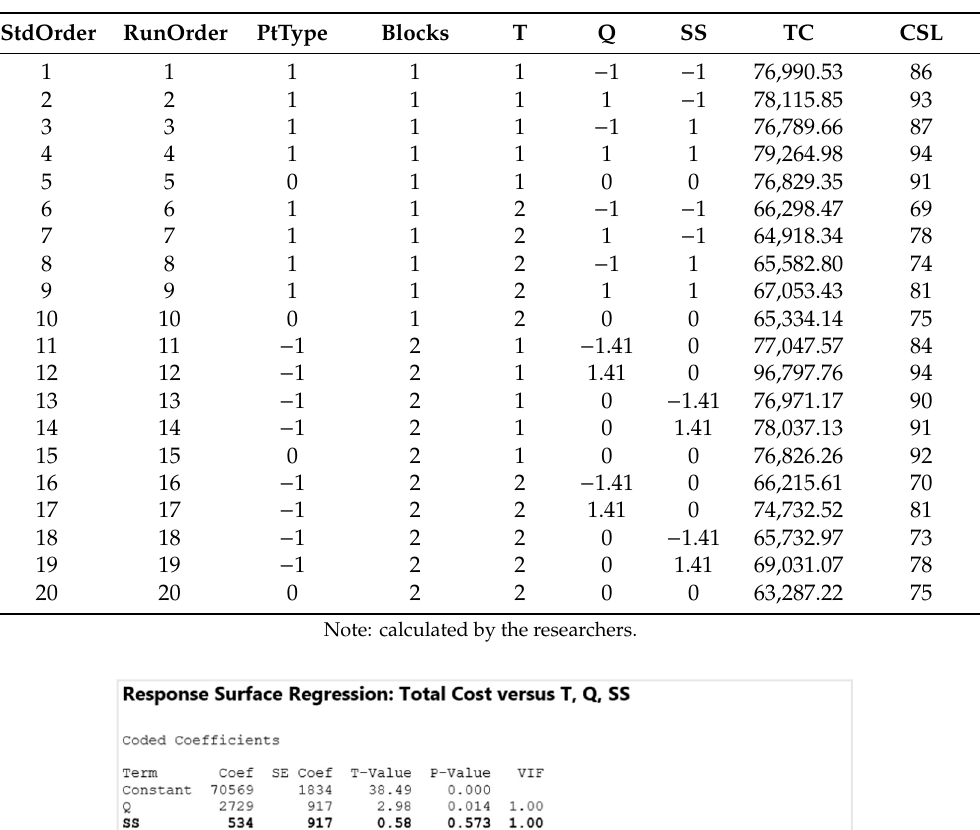
Figure 7. Central composite design running setup. Table 5. Central composite design (one continuous factor and two categorical factors).